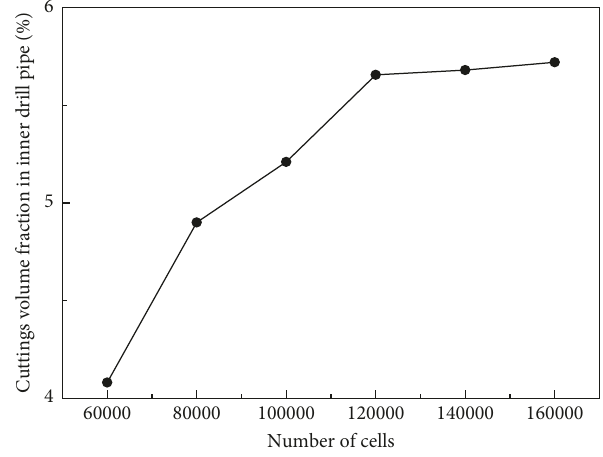
Figure 4: Mesh independence analysis